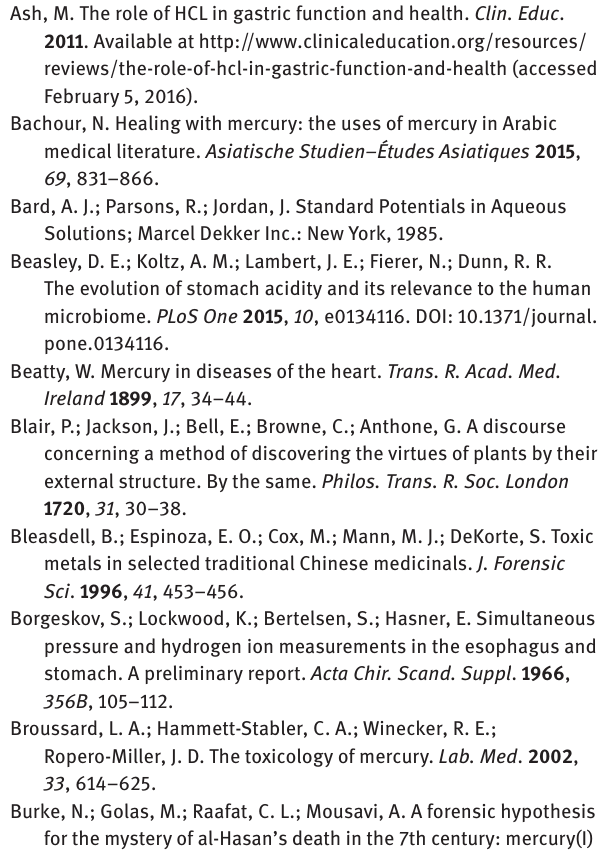
Figure 3: The potential-pH diagram of - 22 310.75 K and 1